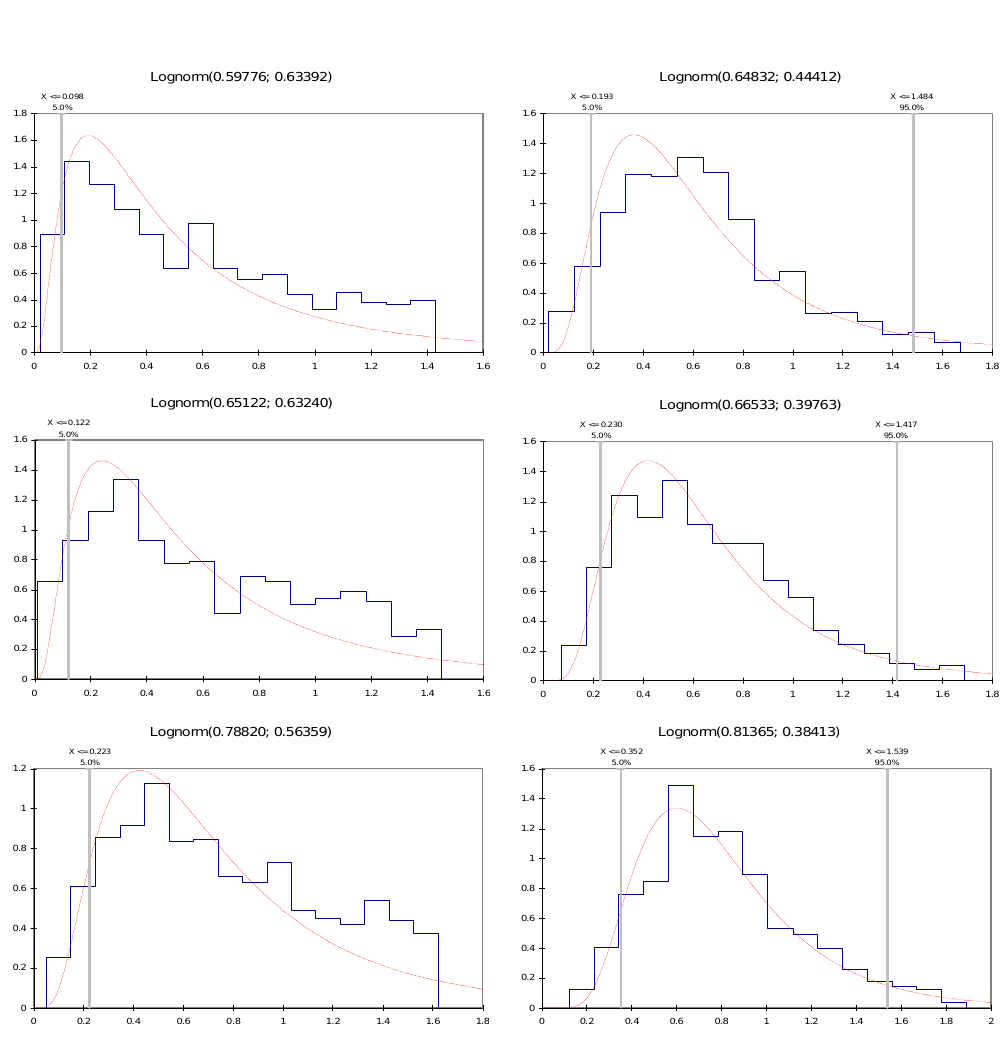
Fig. 4. Uniform flow model. Adaptation of lognormal PDF to transformed water depth variable ( w = y MAX − y ) for n i uniformly distributed (left panels) and normally distributed (right panels), and for flow cases 200m 3 s − 1 (top panels), 300m 3 s − 1 (middle panels) and 500m 3 s − 1 (bottom